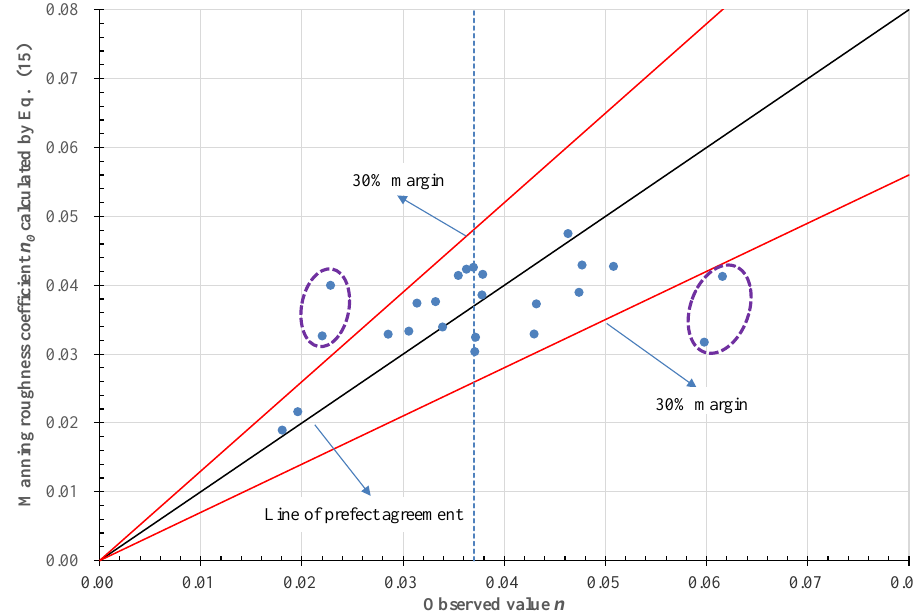
Figure 8. Comparison of the observed and calculated value of Manning ’ s roughness.